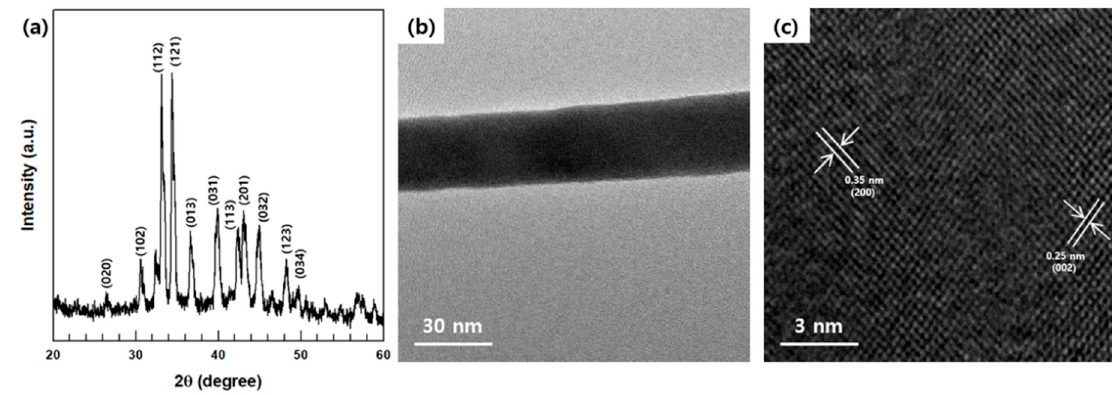
Figure 3. ( a ) XRD patterns, ( b ) Low and ( c ) high magnification images of synthesized Ag 2 Se